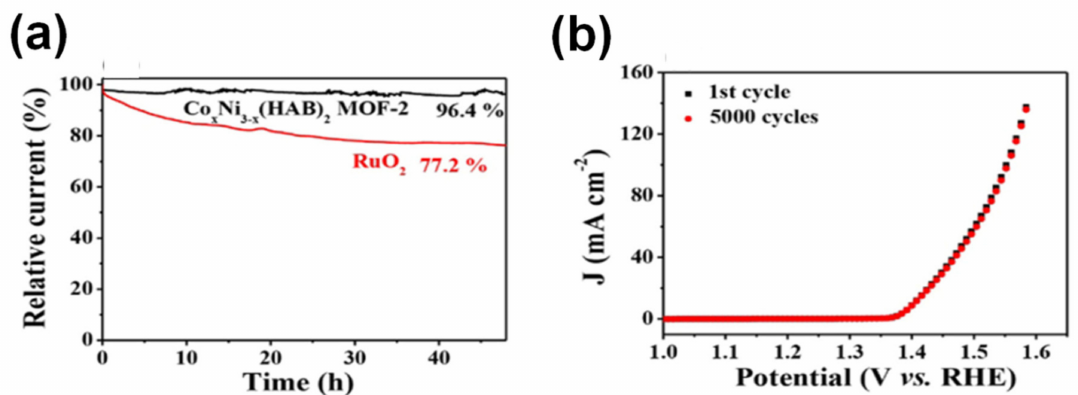
Figure 20. ( a ) The I–t responses for Co x Ni 3-x (HAB) 2 MOF-2 and RuO 2 at a constant η 10 = 1.47 V (vs. RHE) for 48 h in N 2 -saturated 1.0 M KOH solution; ( b ) Polarization curves of the Co x Ni 3-x (HAB) 2 MOF-2 before and after 5000 cycles at a scan rate of 10 mV s -1 . Reproduced with permission from